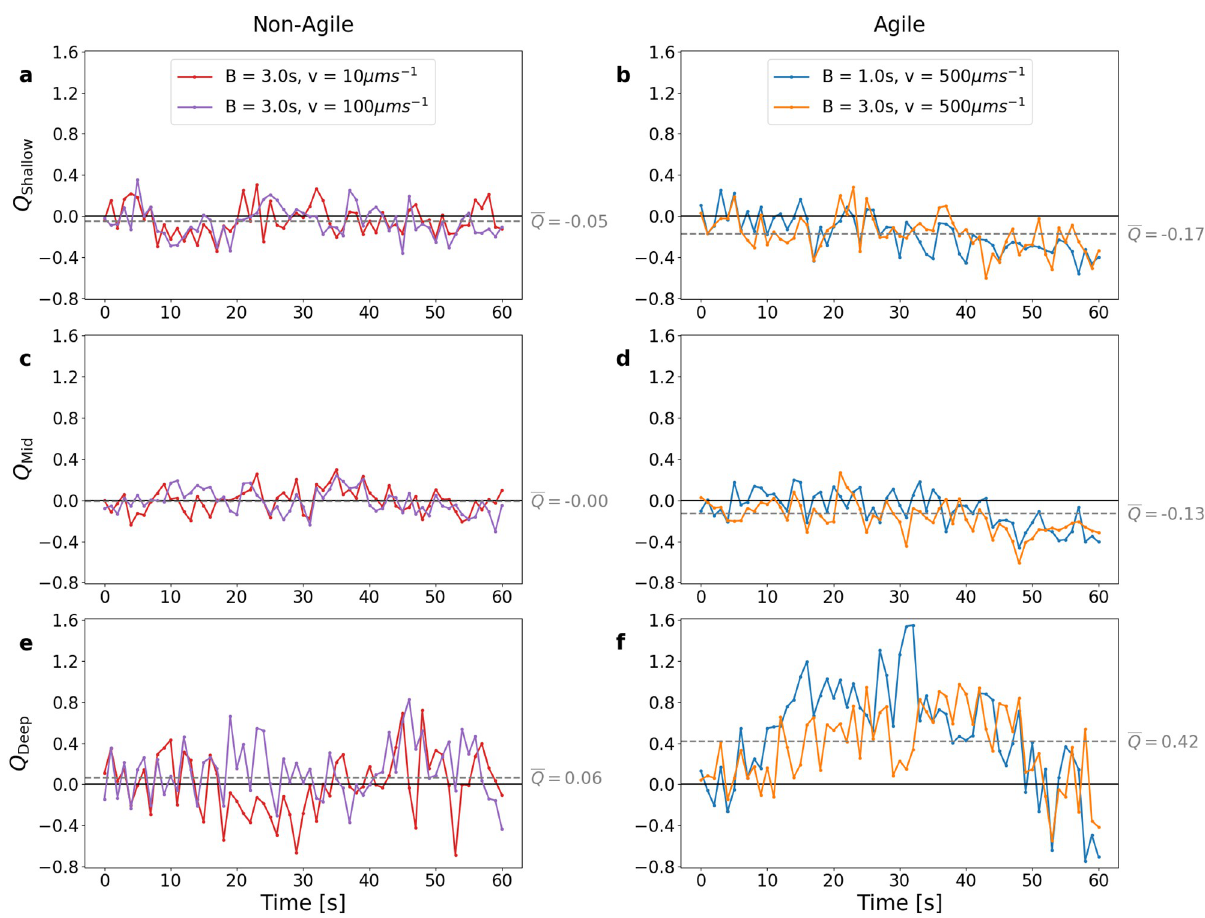
Fig 3. Q -statistic over time (solid lines) in different depth regions. Subplots in the left-hand column, (a), (c), (e) , are from two simulated microbe populations representative of non-agile microbe behaviour. Subplots in the right-hand column, (b), (d), (f) , are from two simulated microbe populations representative of agile microbe behaviour. Within each subplot, the dashed gray line represents the mean value � Q (w.r.t. time) of the Q - statistic for the two simulations and depth region plotted therein. Non-agile microbes were not more concentrated in patches than non-motile microbes, whereas agile microbes in the deep region formed patches over twice as concentrated as non-motile microbes ( Q > 1). Note that agile microbes in the shallower regions exhibited weak but negative mean patch enhancement. Full results for every combination of motility parameters ( B , v swim ) and each depth region are plotted in Figs E, F and G in S3